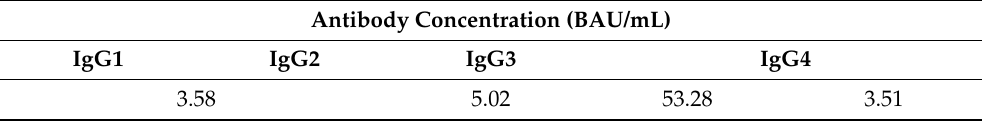
Table 4. Cut-off values for anti-N protein antibodies, calculated for each